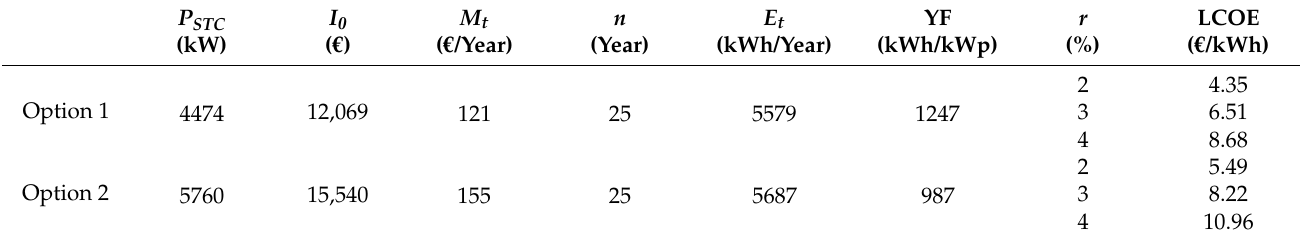
Table 8. Final energy, non-renewable primary energy, and CO 2 emissions per